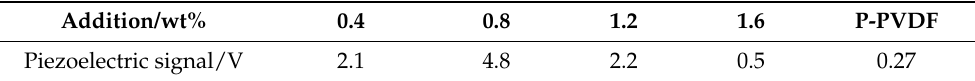
Table 7. Piezoelectric signal of the fiber membrane at different loading of AgNO 3 .